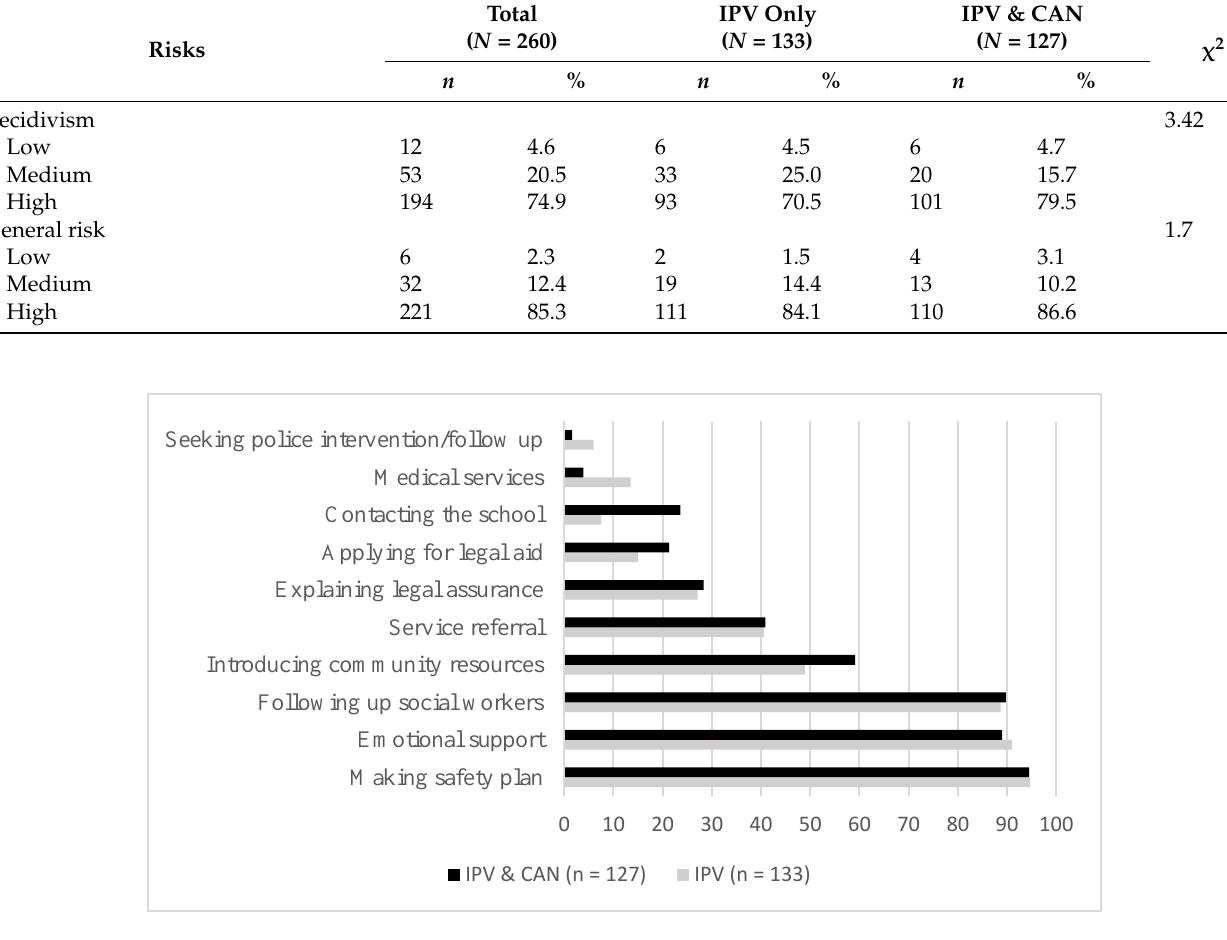
Figure 1. Intervention plan for battered women and children.